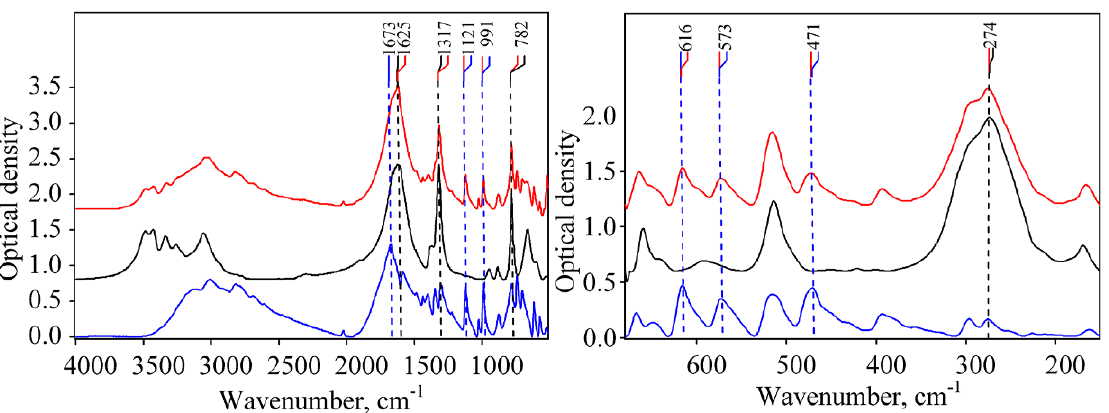
Figure 1. Non-normalized absorption spectra of urinary stone containing uric acid and calcium oxalate: A – KBr pellet MIR (top – urinary stone, middle – pure calcium oxalate, bottom – pure uric acid); B – PE pellet FIR (top – urinary stone, middle – pure calcium oxalate, bottom – pure uric acid). The spectra have been vertically shifted for clarity.